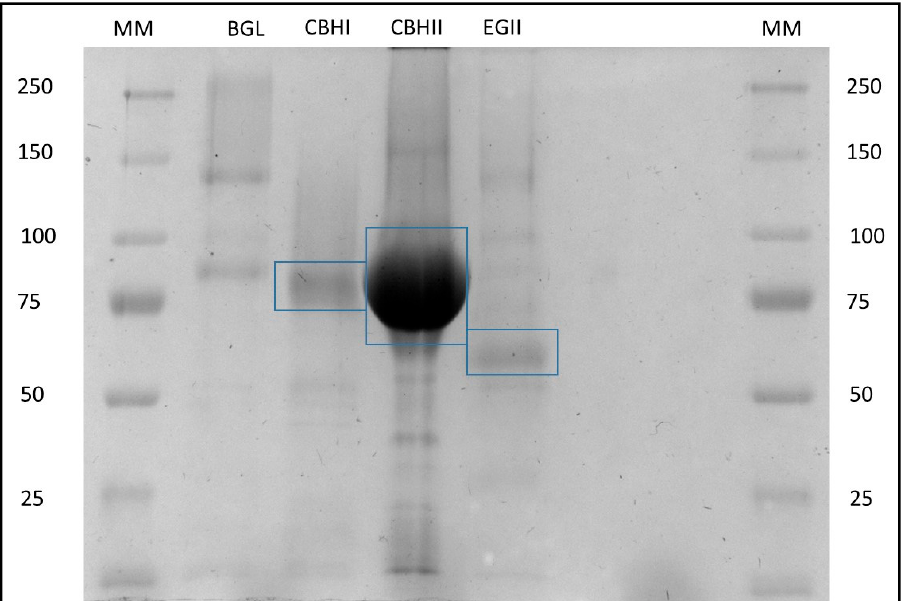
Figure 2. Denaturing 12% sodium dodecyl sulphate-polyacrylamide gel electrophoresis (SDS-PAGE) of ultrafiltration-concentrated mono-component cellulases (15 µL) visualised by Coomassie Brilliant Blue R-250 staining. Molecular mass marker (MM) (BioRad Precision Plus Protein Standards); the blue rectangles represent the identified protein molecular masses corresponding to the literature.